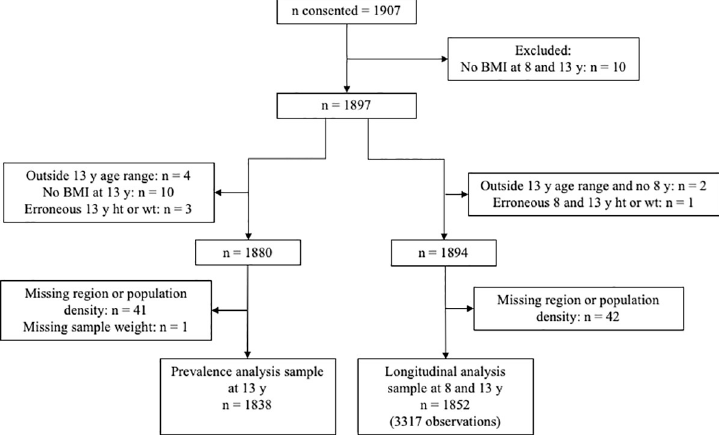
Fig 1. Description of how the analysis sample of adolescents was derived from recruitment for the prevalence and longitudinal analyses. BMI, Body mass index; ht, height; wt, weight; y, years.